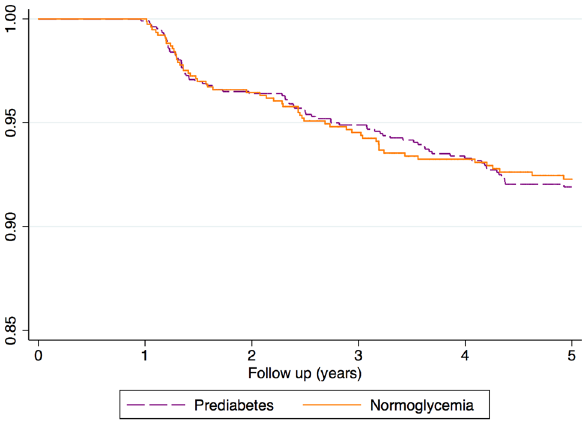
Figure 2. Kaplan–Meier survival estimate showing time to IRF onset according to prediabetes status.